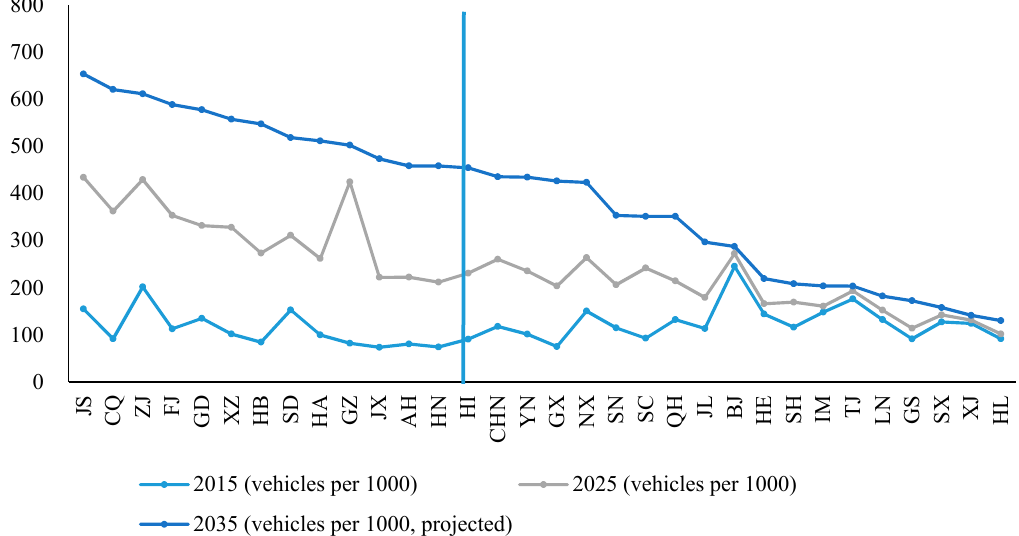
Figure 4. Provincial projections of vehicle ownership per 1000 people in 2035.